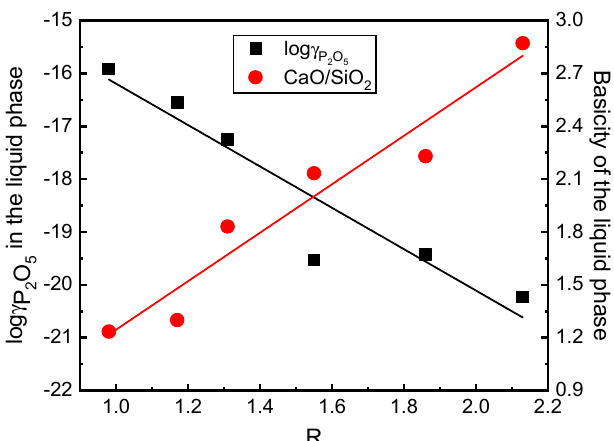
Figure 9. Effect of the basicity of the dephosphorization slag on the γ ( P liquid phase.